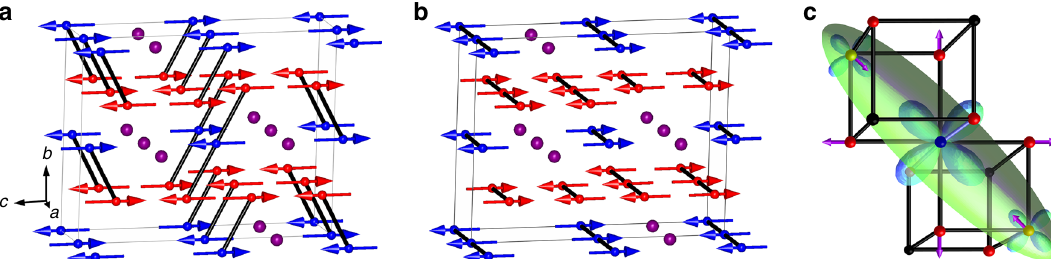
Fig. 3 Magnetic structures for the two phases of CaFe 3 O 5 . Fe1/Fe2 spins are shown in red/blue and Ca ions in purple. a Magnetic structure of the charge ordered (CO) phase CaFe 3 O 5 with propagation vector (½ 0 0), with lines showing ferromagnetic order within trimerons. b Magnetic structure of the charge averaged (CA) phase, with (0 0 0) propagation and lines showing the ferromagnetic chain parallel to the x axis. c A trimeron unit as found in the CO structure ( a ) with bonding electron density represented as an ellipsoid. The size of the t 2g orbitals approximates the atomic populations. The atomic displacement arrows indicate the elongation of the four Fe – O bonds perpendicular to the Jahn – Teller contracted axis and the shortening of the cation – cation distances due to weak Fe – Fe bonding interactions